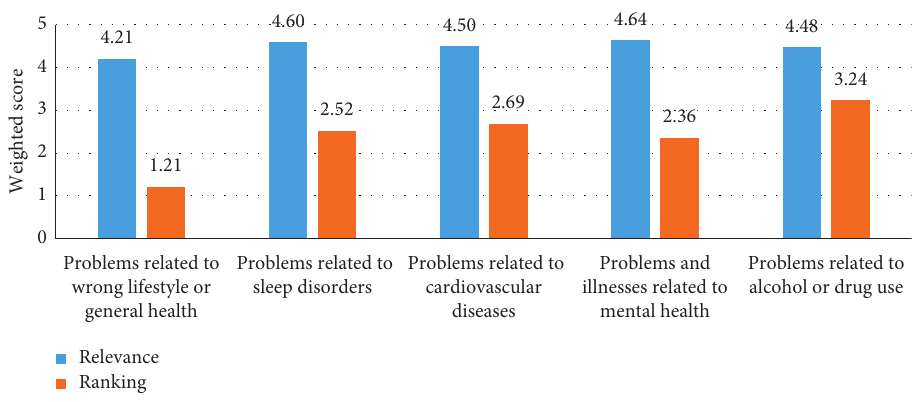
Figure 4: Weighted mean of relevance and priority ranking related to Question